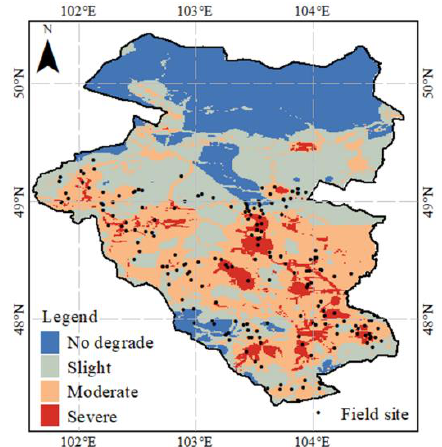
Figure 10. An integrated map of land degradation for the period 2000-2018 with field-measured biomass